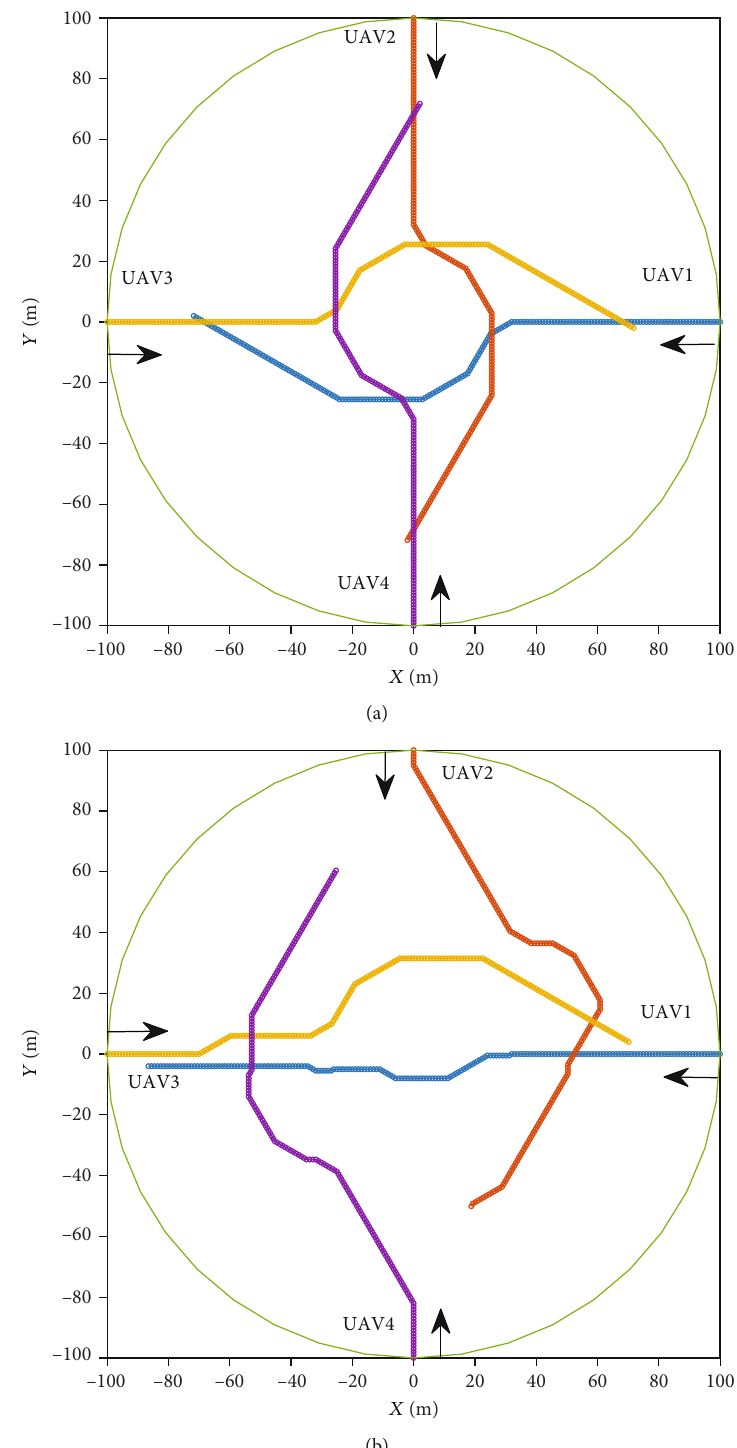
Figure 17: Priority allocation strategy of UAV: (a) strategy without considering priority and (b) priority allocation based on “ coalition complaint value.